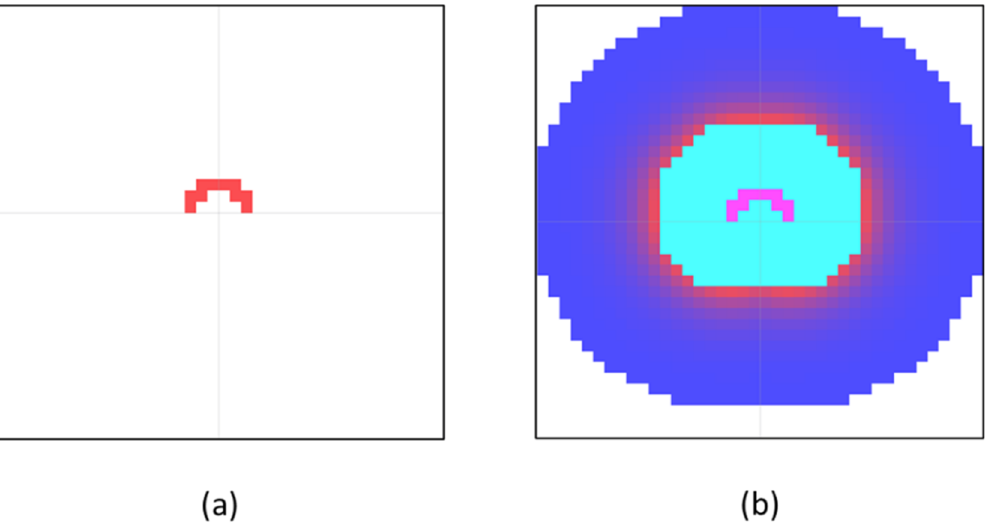
Figure 10. Costmap inflation in the Avoid-Obstacle-Proximity behavior: ( a ) the costmap produced from LiDAR sensing a construction cone; ( b ) the costmap produced from creating a buffer zone of inflated costs around the construction cone.